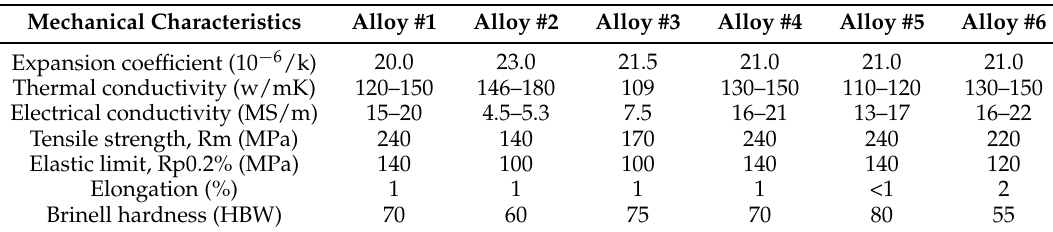
Table 2. Main properties of the studied